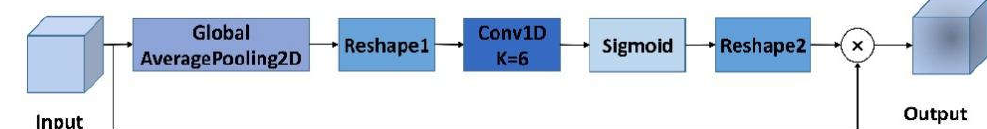
Figure 6. Structure of ECA module.